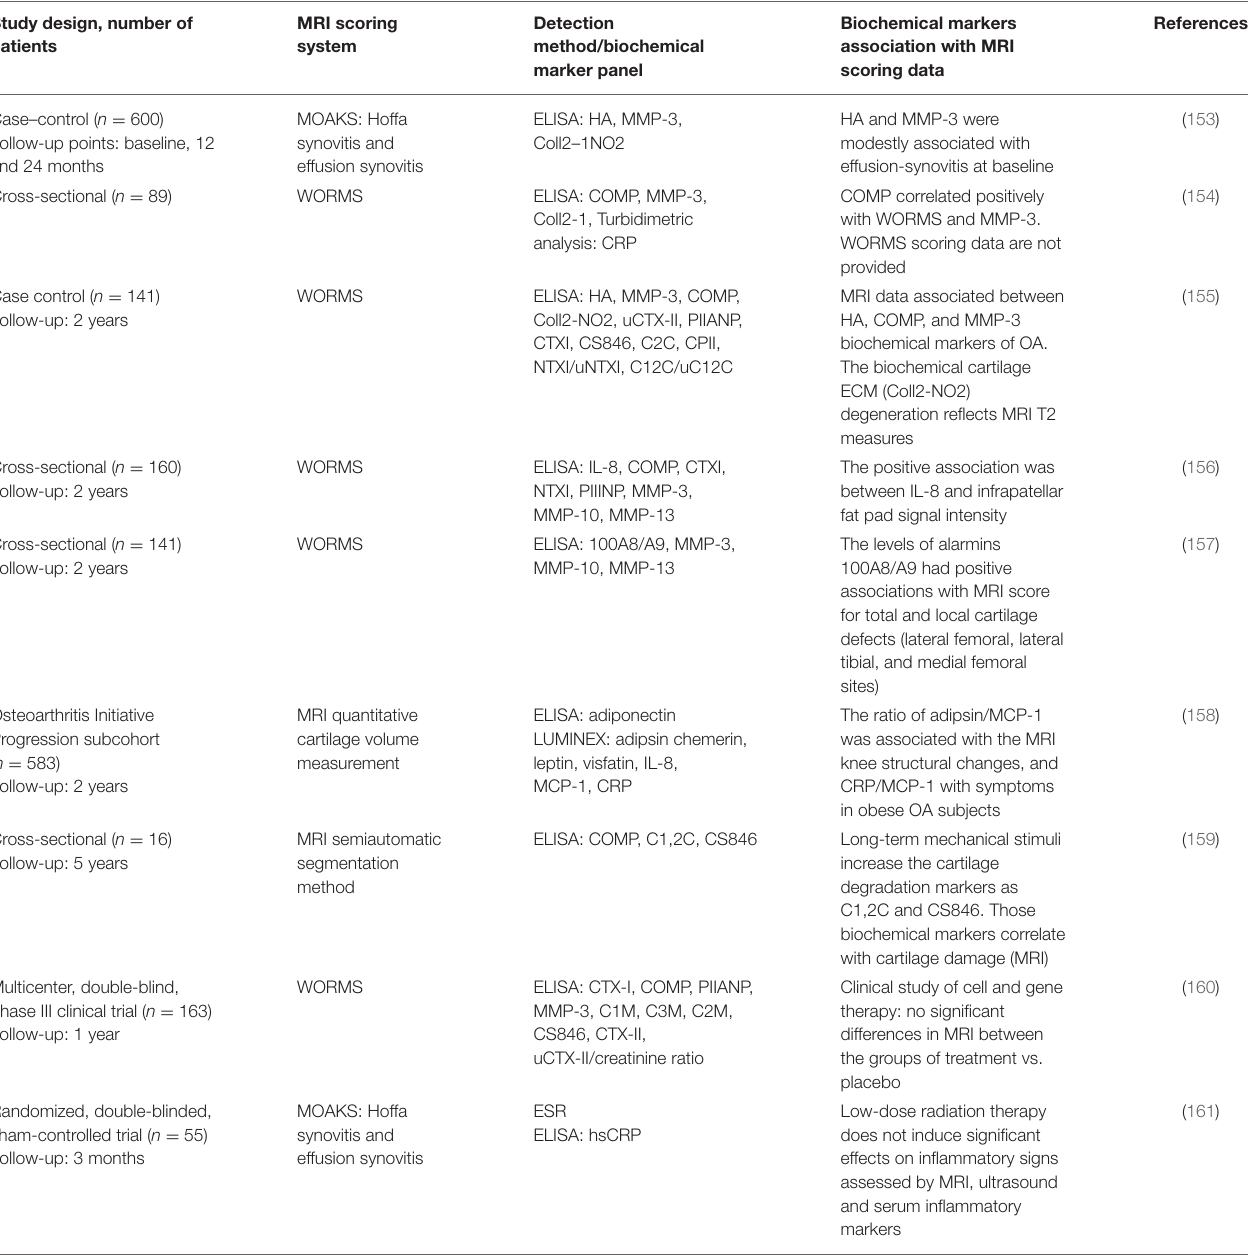
TABLE 4 | Correlation between biochemical marker levels and MRI